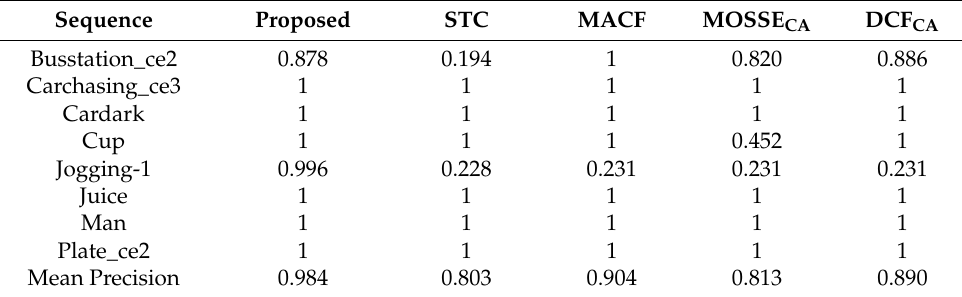
Table 1. Distance precision rate at threshold of 20 pixels.